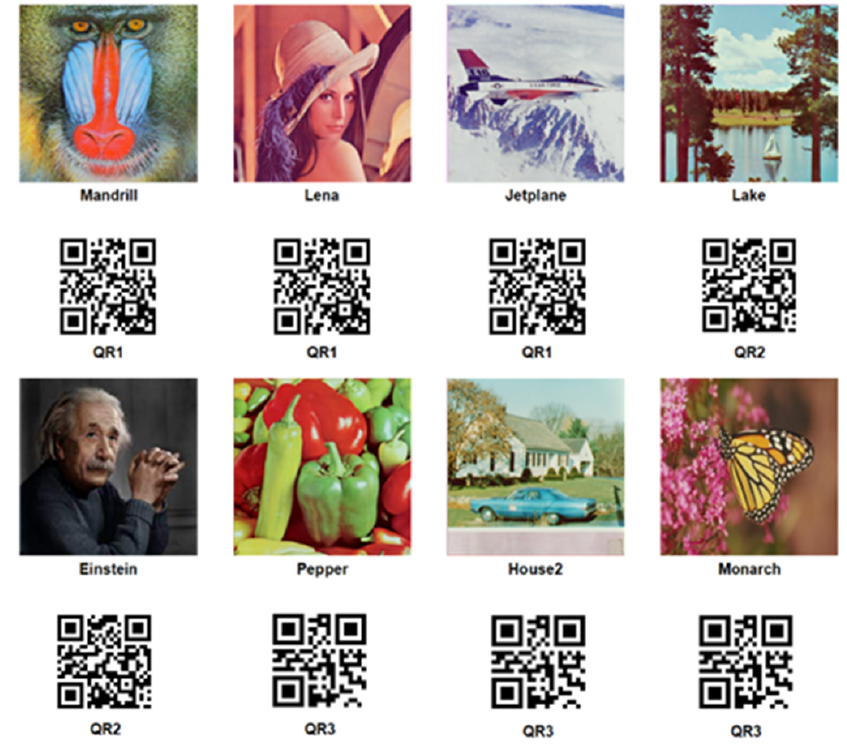
Figure 7. Sample watermarked images and extracted watermarks.